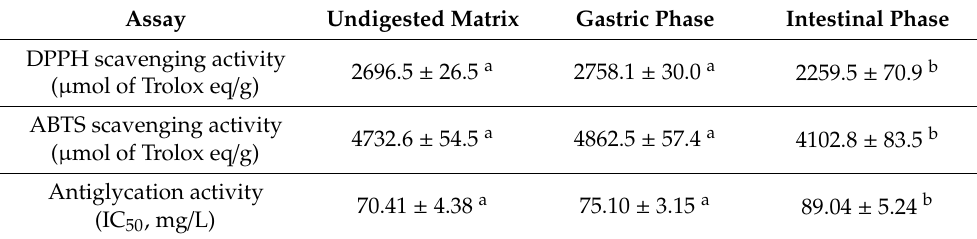
Table 3. Impact of in vitro gastrointestinal digestion on radical scavenging and antiglycation activities of Vaccinium myrtillus fruit extract.